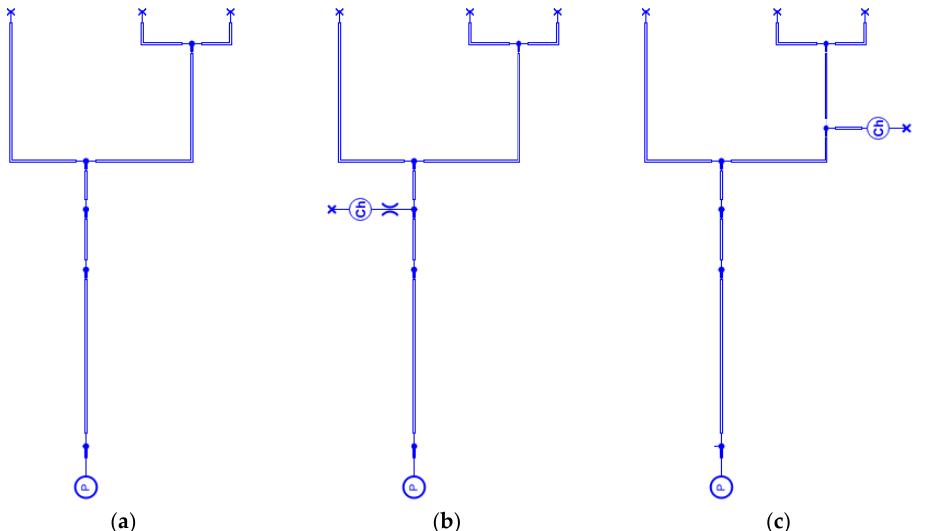
Figure 8. Hydraulic circuits for the linear analysis: ( a ) base circuit; ( b ) base circuit with the accumulator; ( c ) base circuit with the Helmholtz resonator.